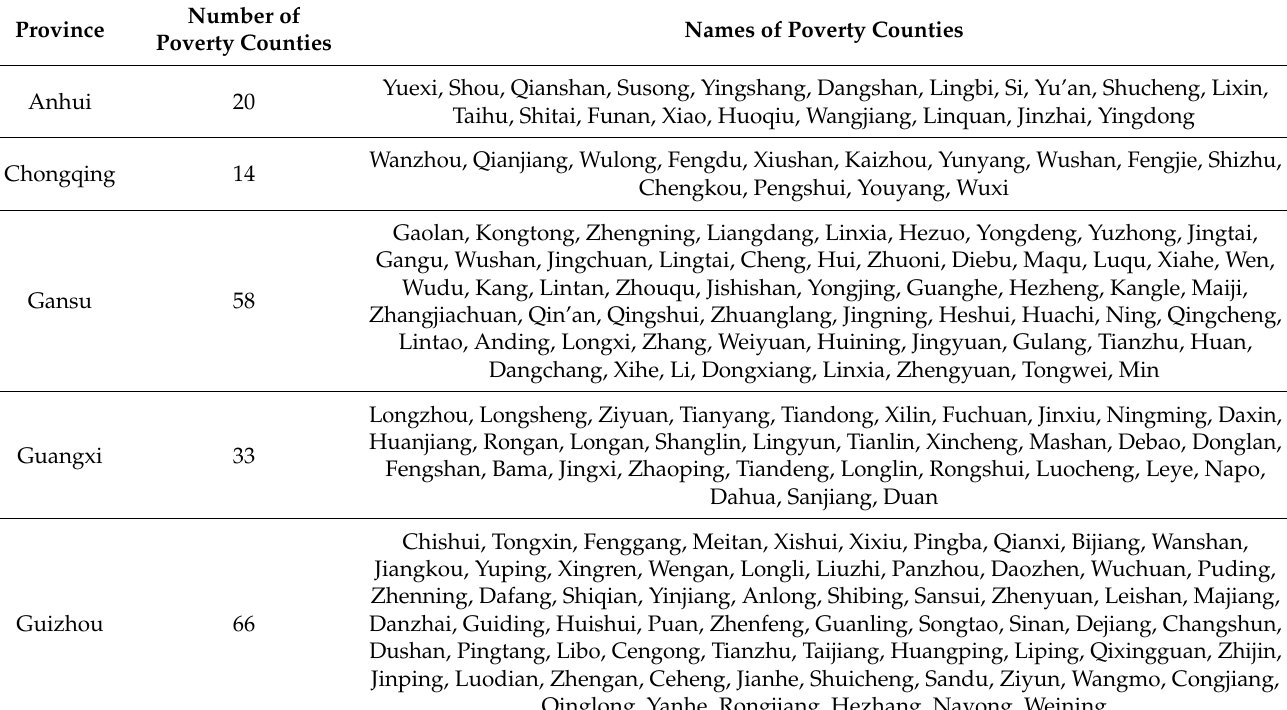
Table A1. List of the 832 national-level poor